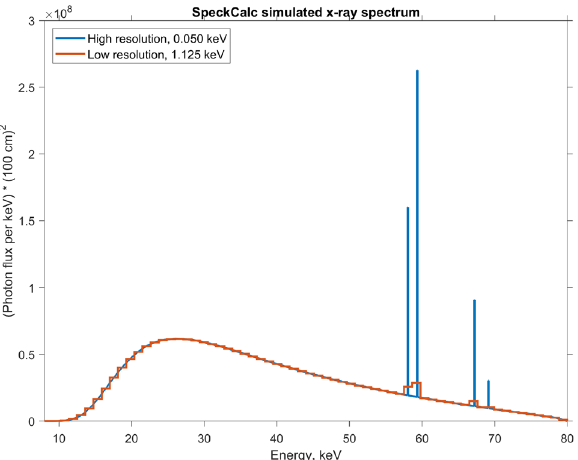
Figure 4. Source spectrum simulation from SpekCalc. The number of photons is proportional to the source current and exposure time, which we have assumed to be 10 mA and 0.1 ms, or 1 mC of electron